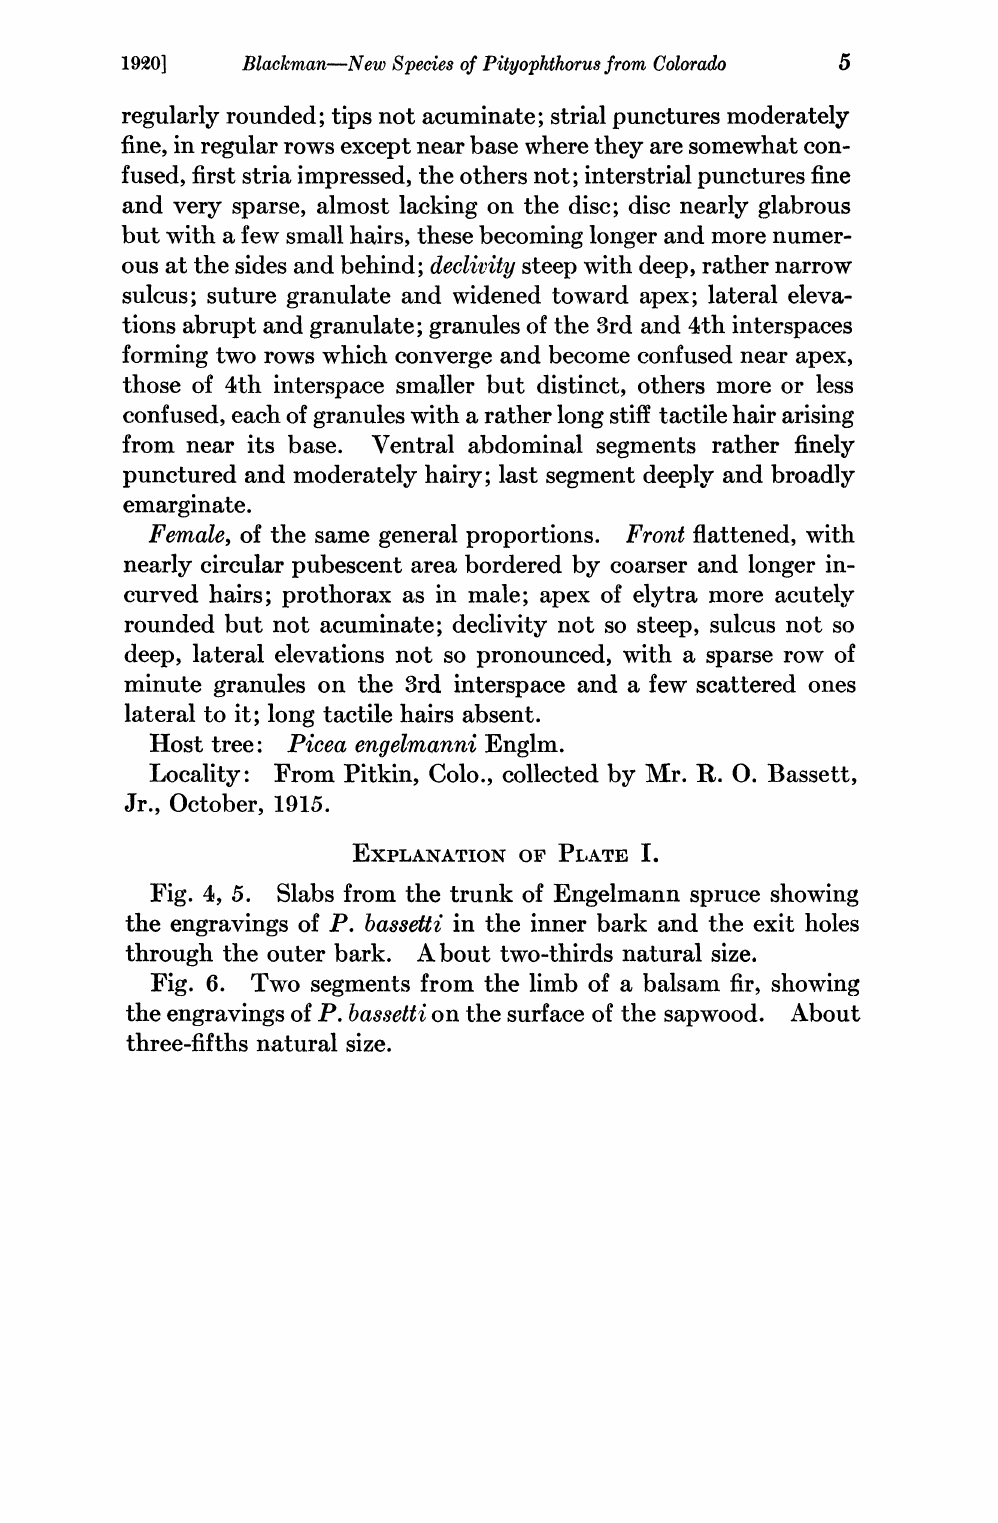
. Slabs from the trunk of Engelmann spruce showing the engravings of P. baaetti in the inner bark and the exit holes through the outer bark. Two segments from the limb of a balsam fir, showing the engravings of P. baetti on the surface of the sapwood. About three-fifths natural